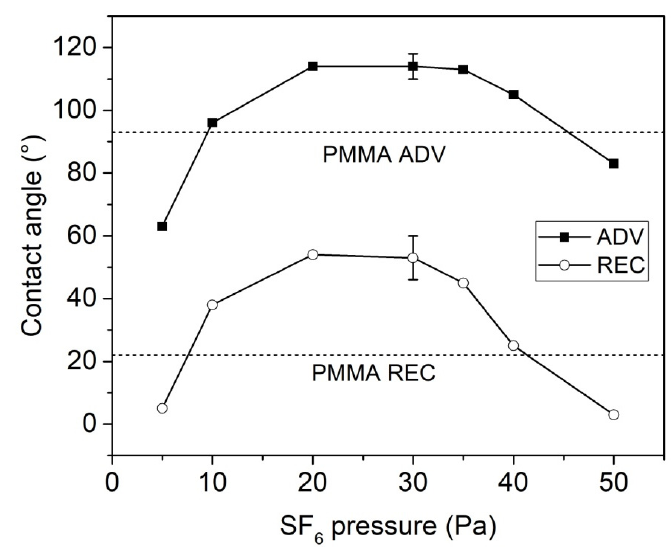
Figure 1. Advancing and receding contact angles of plasma-treated intraocular lenses (IOLs) as a function of the SF 6 pressure (peak power = 70 W, DC = 50%). The two horizontal dashed lines represent the values of the untreated poly(methyl methacrylate) (PMMA).